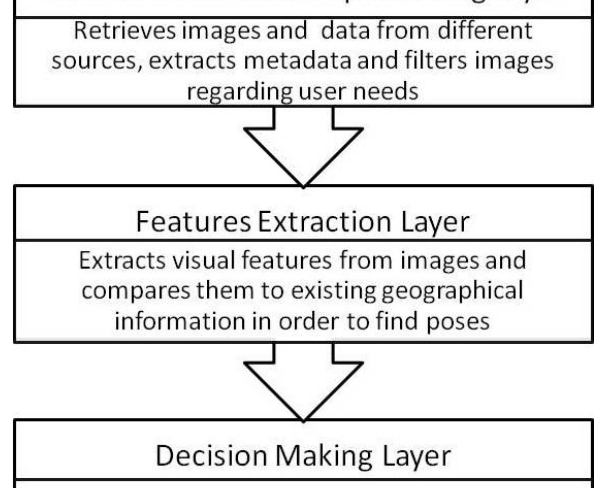
Figure 1. Proposed system